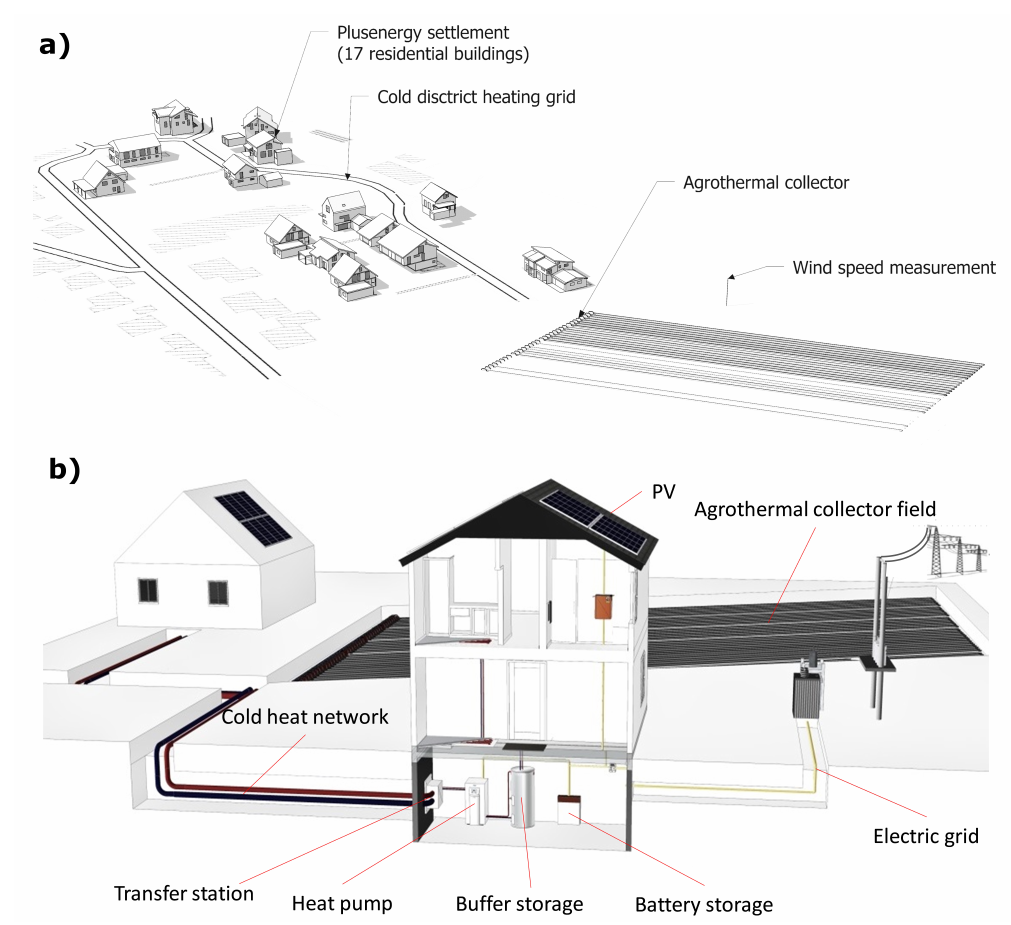
Figure 4. ( a ) The Wüstenrot pilot site “ Vordere Viehweide ”. ( b ) Schematic of the building